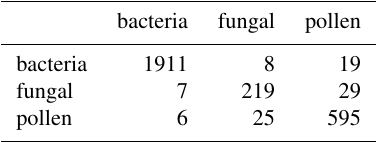
Table 10. Matching matrix for the best case scenario when using gradient boosting. This is when using 9 σ on the 2014 data.